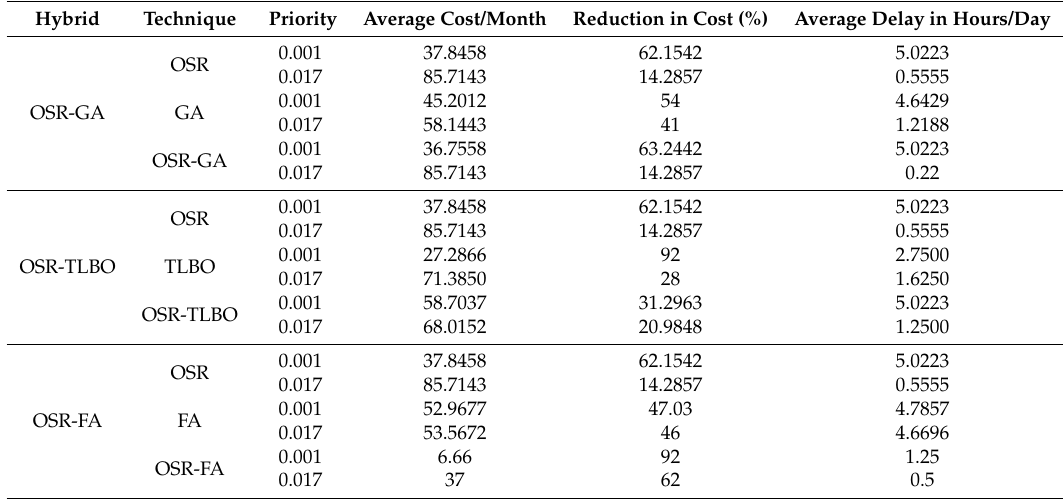
Table 7. Dishwasher Simulation Statistics.